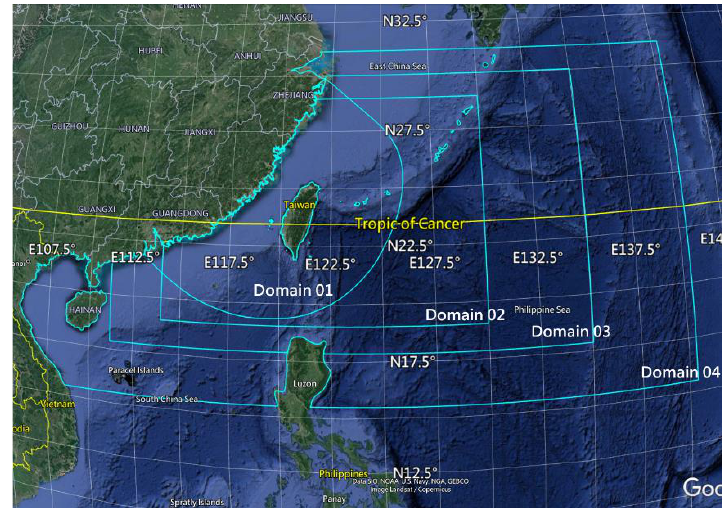
Figure 2. Four computational domains of the SCHISM-WWM-III adopted in the present study. Table 2. Characteristics of computational domains D01 to D04.